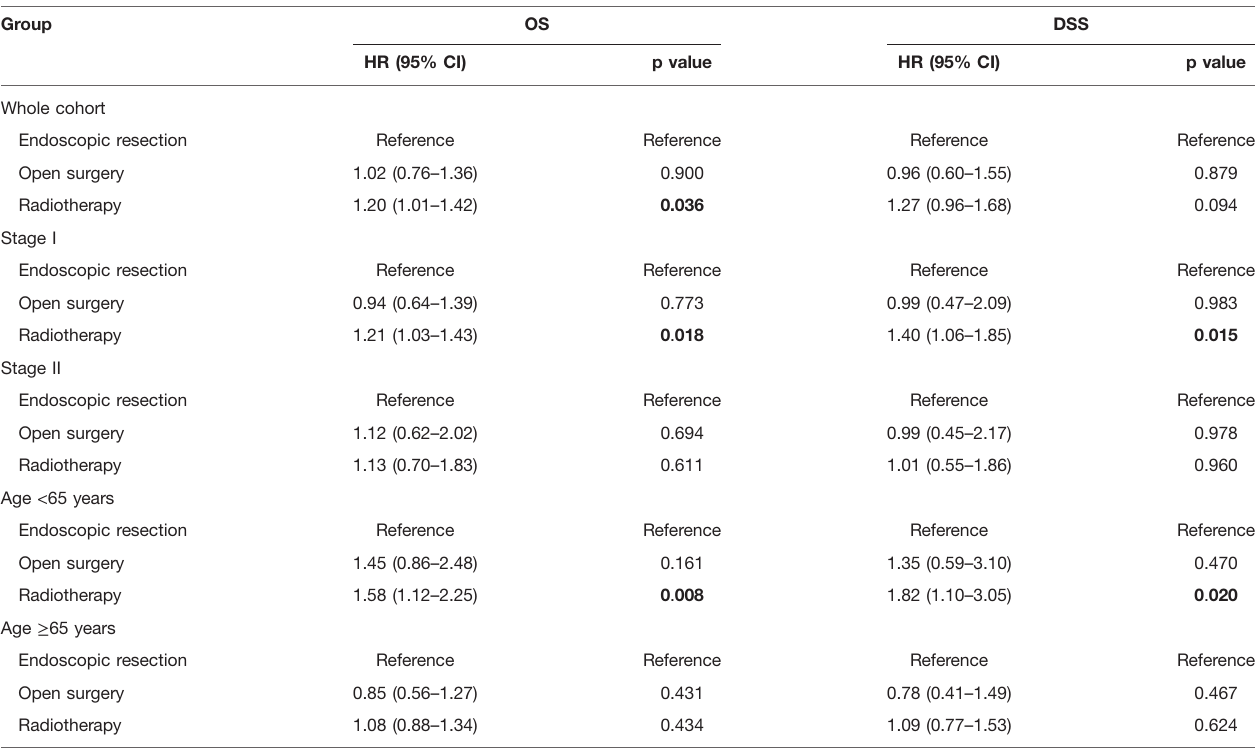
TABLE 2 | Cox proportional hazards regression